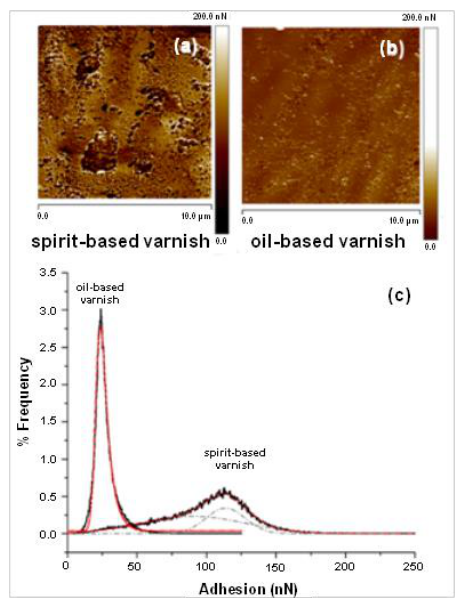
Figure 6. The PeakForce adhesion image of the naturally aged spirit-based sample (sample 6)